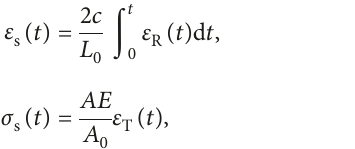
Figure 2: Typical shaped